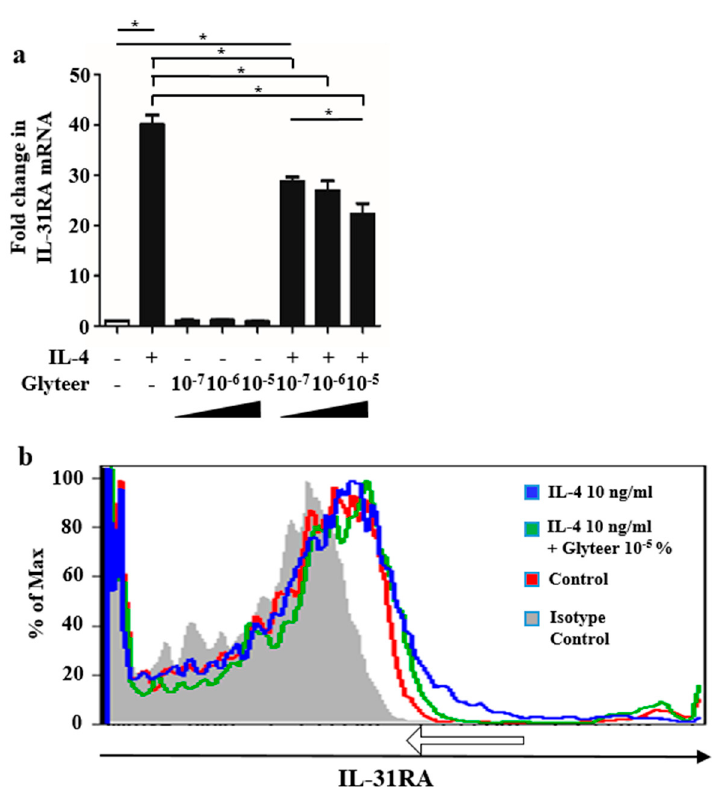
Figure 3. Glyteer impaired IL-4-induced IL-31RA expression. ( a ) Data are expressed as mean ± standard error of the mean (S.E.M.); n = 3 for each group; * p < 0.05. Expression of IL-31RA mRNA in BMDCs stimulated with or without IL-4 (10 ng / mL) and Glyteer (10 − 7 , 10 − 6 and 10 − 5 %) for 24 h. ( b ) BMDCs were treated with or without IL-4 (10 ng / mL) and Glyteer (10 − 5 %) for 24 h. IL-31RA expression was evaluated using anti-murine IL-31RA antibody. IL-31RA-positive cells increased upon stimulation with IL-4 (10 ng / mL), compared with that in the control group, which was inhibited by Glyteer treatment (10–5%) (around the area indicated by a white arrow). Data is representative of experiments repeated three times with similar results.